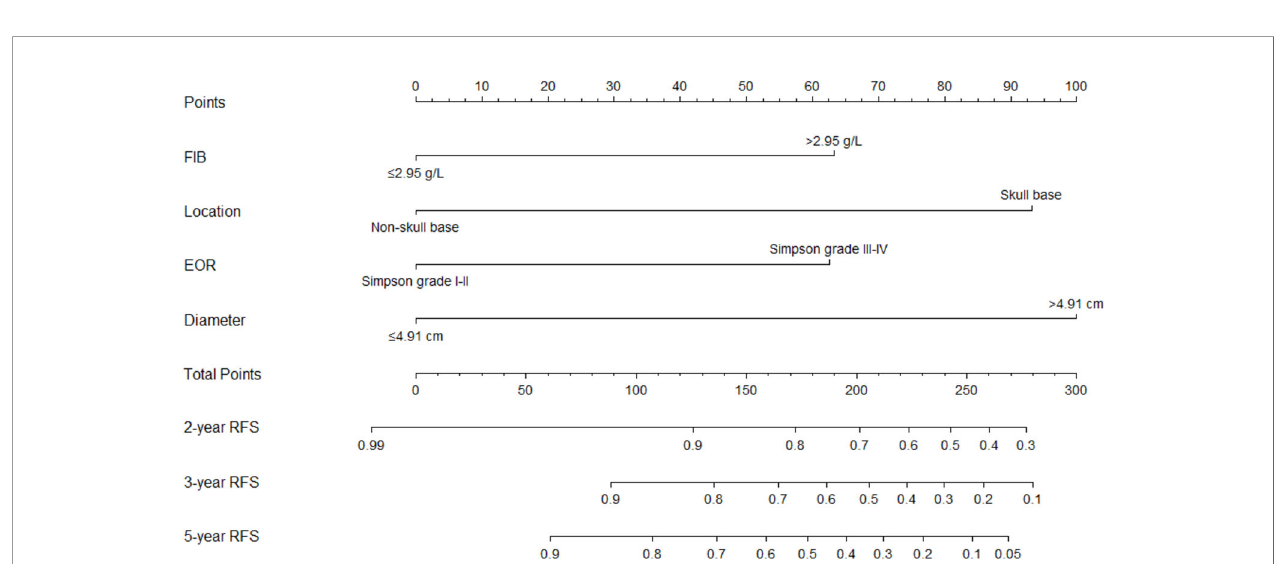
FIGURE 5 | The nomogram for predicting 2-, 3-, and 5-year recurrence-free survival rate of a typical meningioma patients. FIB, fi brinogen; EOR, extent of resection; RFS, recurrence-free